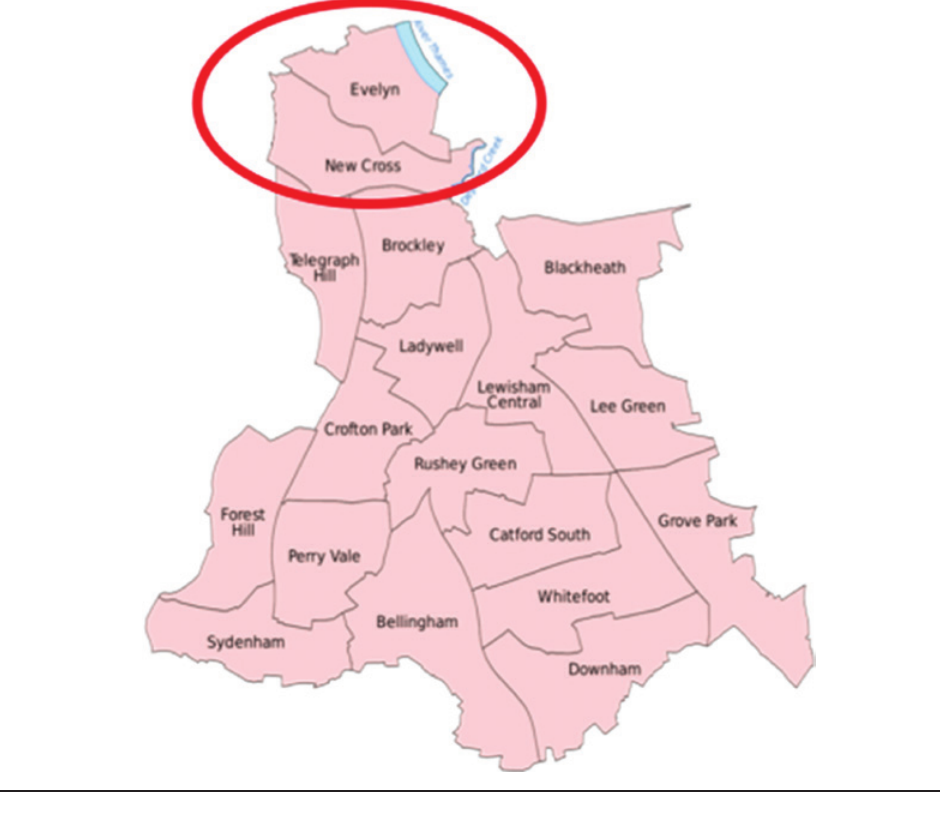
figure 5: Deptford takes in evelyn and New cross wards in the north of the borough (source: Wikipedia lewisham london UK labelled ward map 2002.svg licensed under cc BY-sa 3.0)